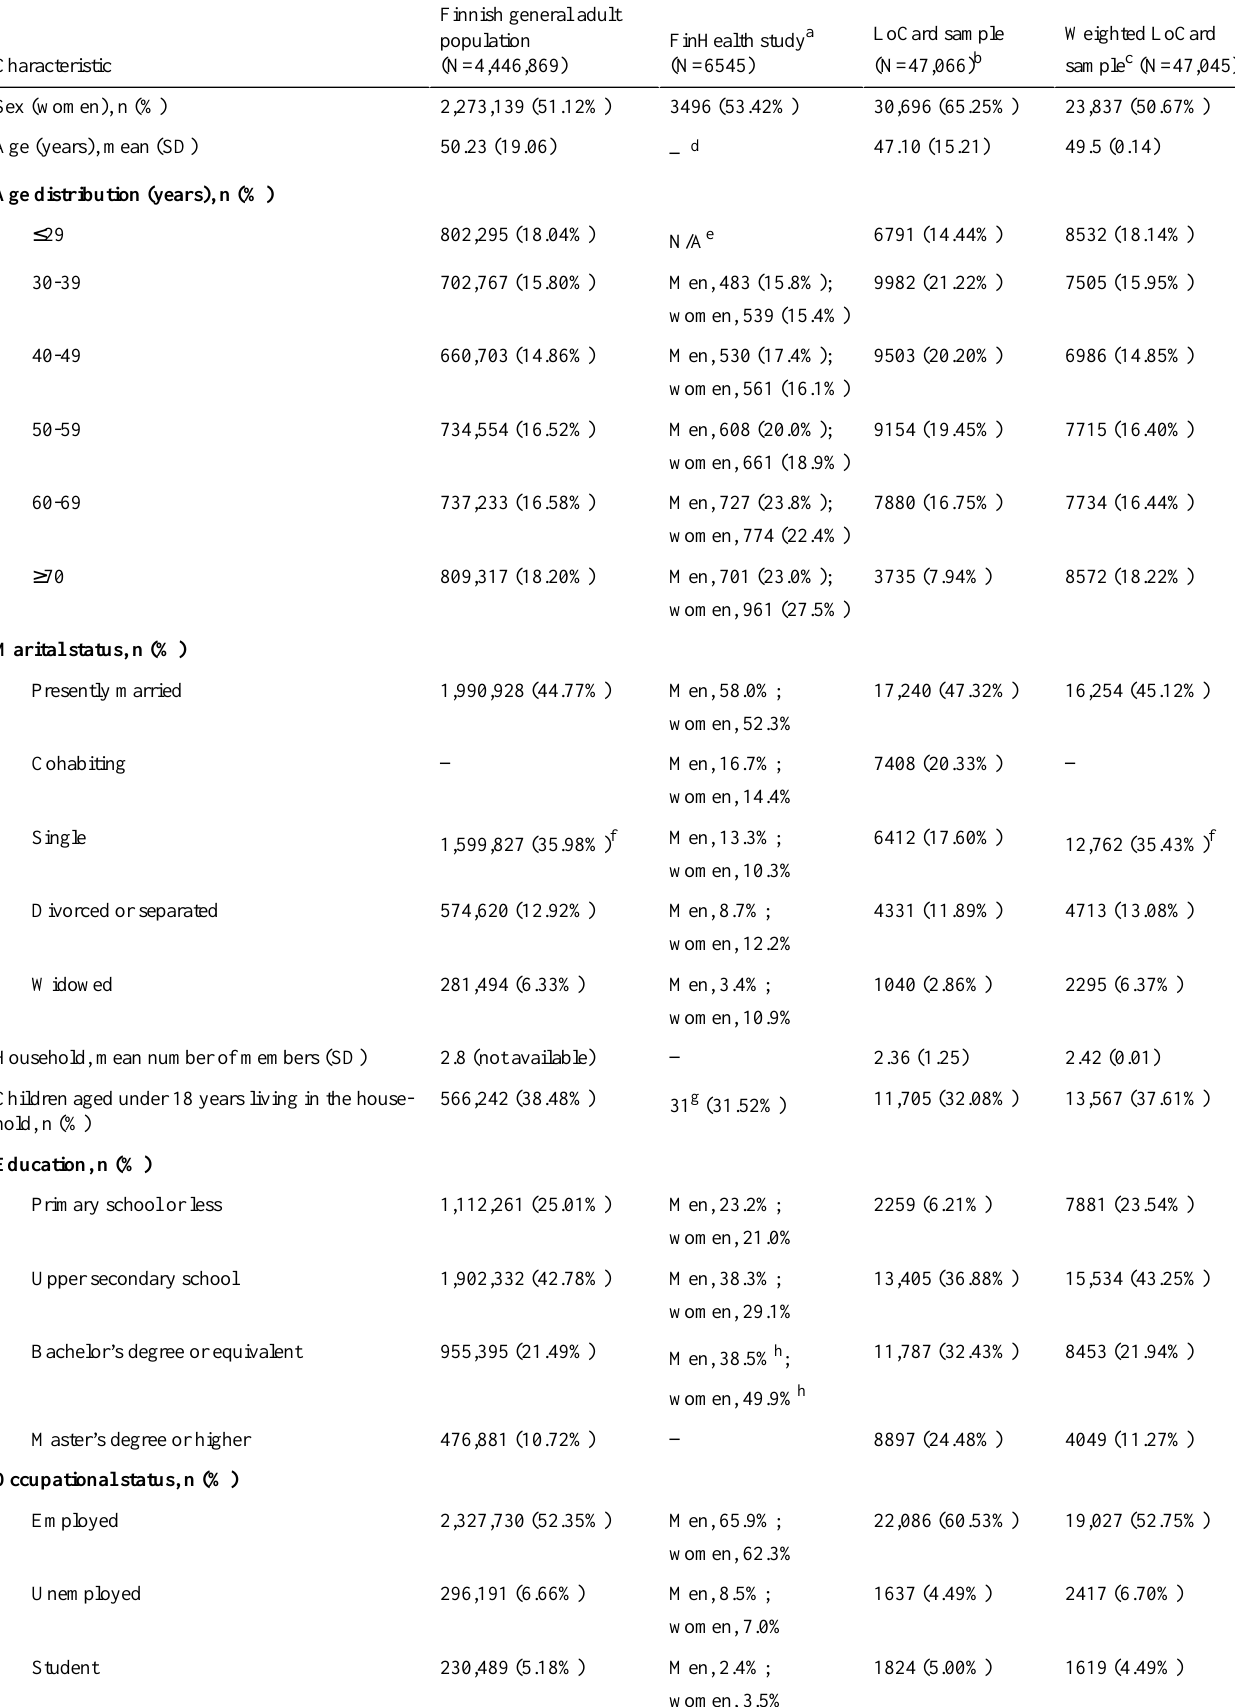
Table 1. LoCard participant characteristics compared with those of the general Finnish adult population and participants of the FinHealth study.